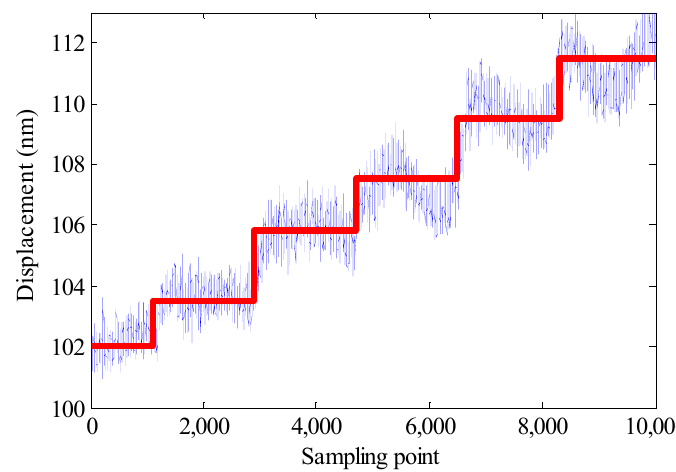
Figure 4. Experimental setup for resolution and stability test.